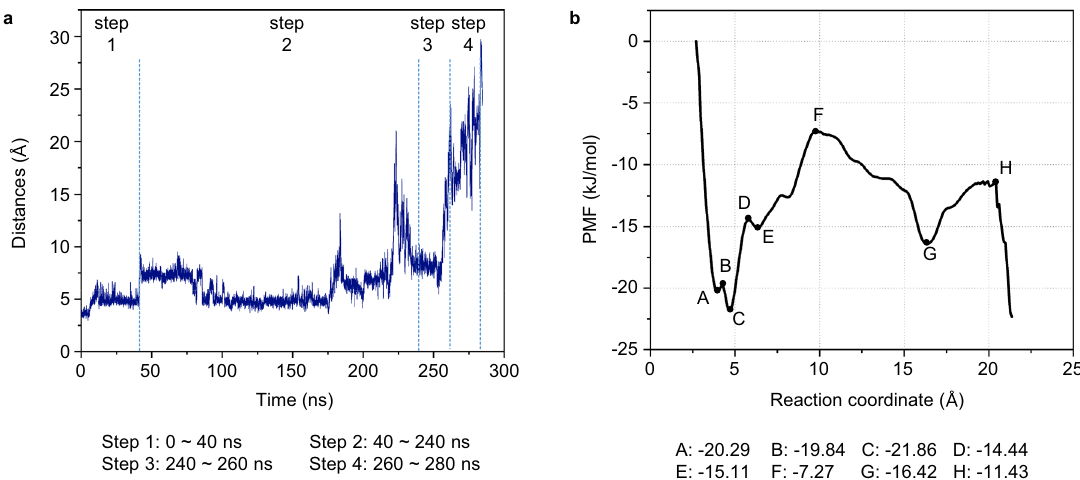
Fig. 4 Reaction coordinate and energy landscape of the release process. a The distance between the N17 atom of the aminomethyl lipoate arm and the center of mass (COM) of Glu-12 and Glu-14 in protein H as the reaction coordinate and its change a function of time of the induction process of protein T. b Potential of Mean Force (PMF) pro fi le of the induction process as a function of the reaction coordinate generated using umbrella sampling simulations and the Weighted Histogram Analysis Method (WHAM).